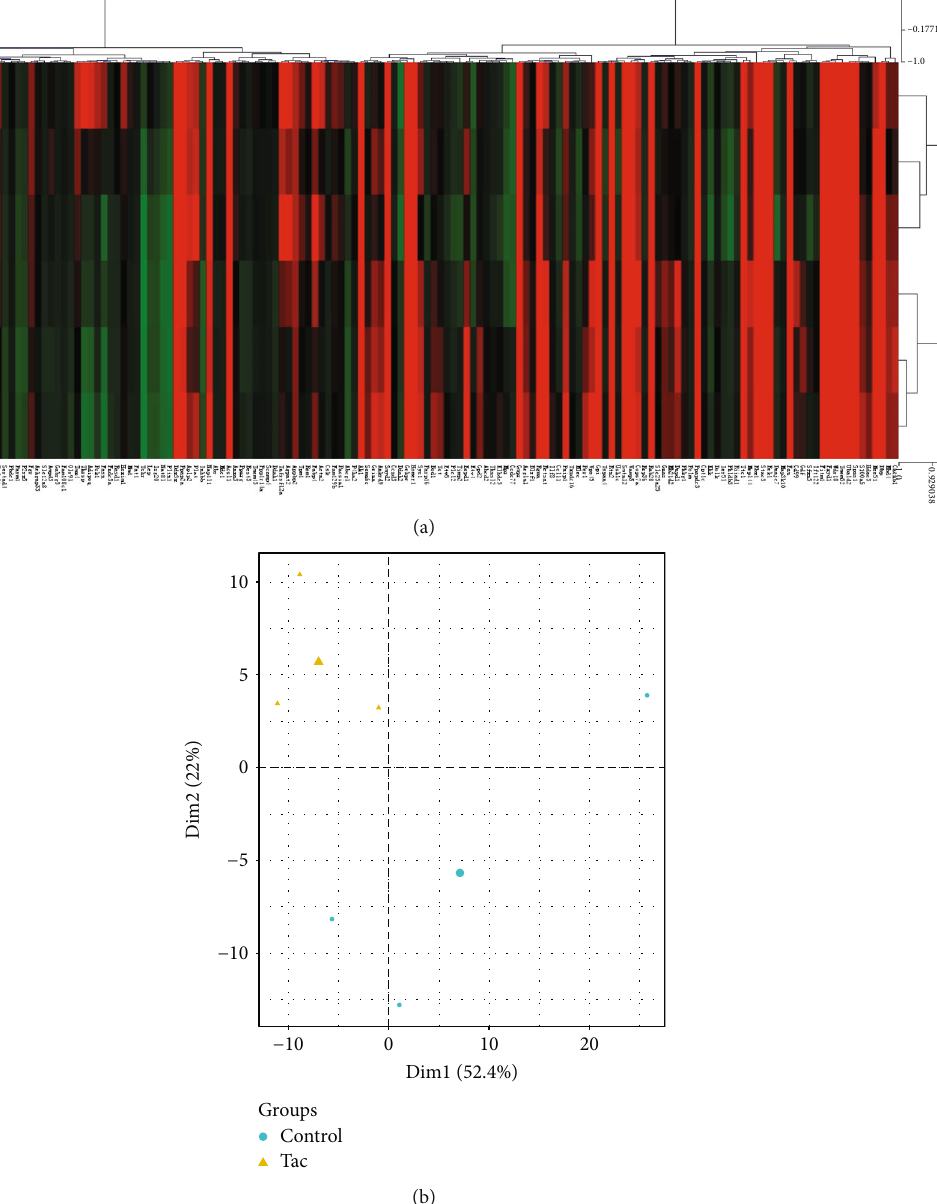
Figure 2: Di ff erentially expressed genes pro fi les. Heat map of DEGs in Tac rats and controls (a). Principal component analysis (PCA) of DEGs